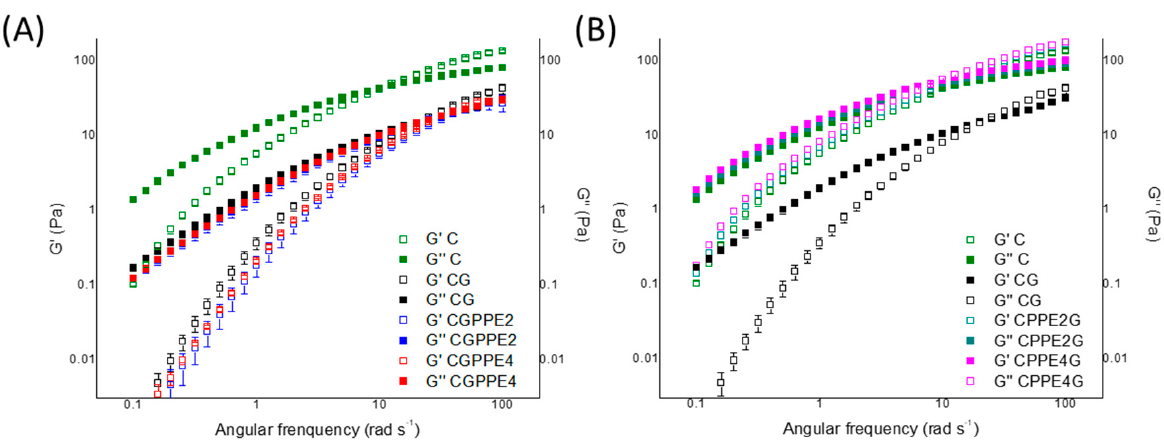
Figure 2. Frequency dependency of G (cid:48) and G (cid:48)(cid:48) moduli at 10% of strain and 25 ◦ C for: ( A ) C, CG, CGPPE2, and CGPPE4; and ( B ) C, CG, CPPE2G, and CPPE4G. Table 2. Parameters determined by frequency sweep measurements: angular frequency at the cross- over point ( ω crossover ) and G’ modulus at the crossover point (G’ crossover ). Measurements performed at γ = 10% and 25 °C.